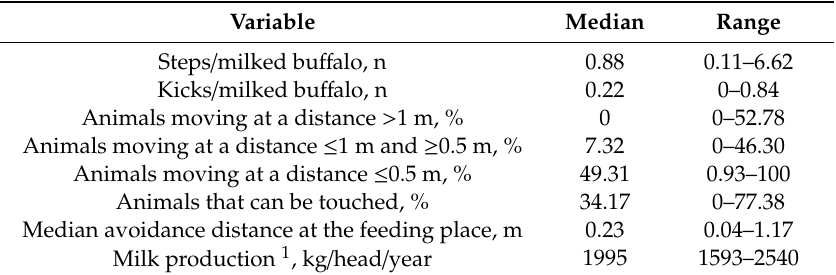
Table 4. Median and range of the variables observed in the animals (n =